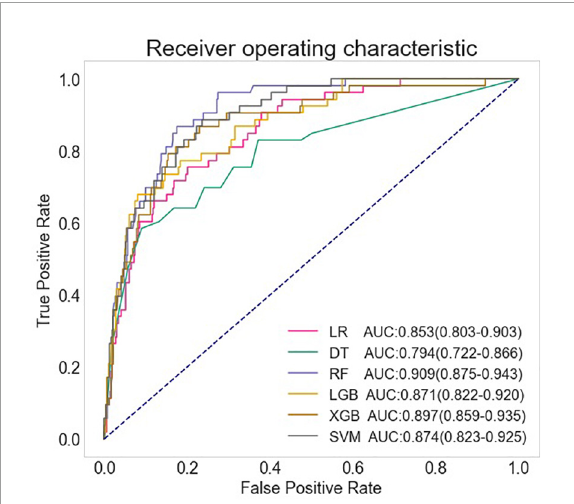
FIGURE1 Comparison of AUCs among different machine learning models. LR, logistic regression; DT, decision tree; RF, random forest classifier; LGB, light gradient boosting machine; XGB, extreme gradient boosting machine; SVM, support vector machine.